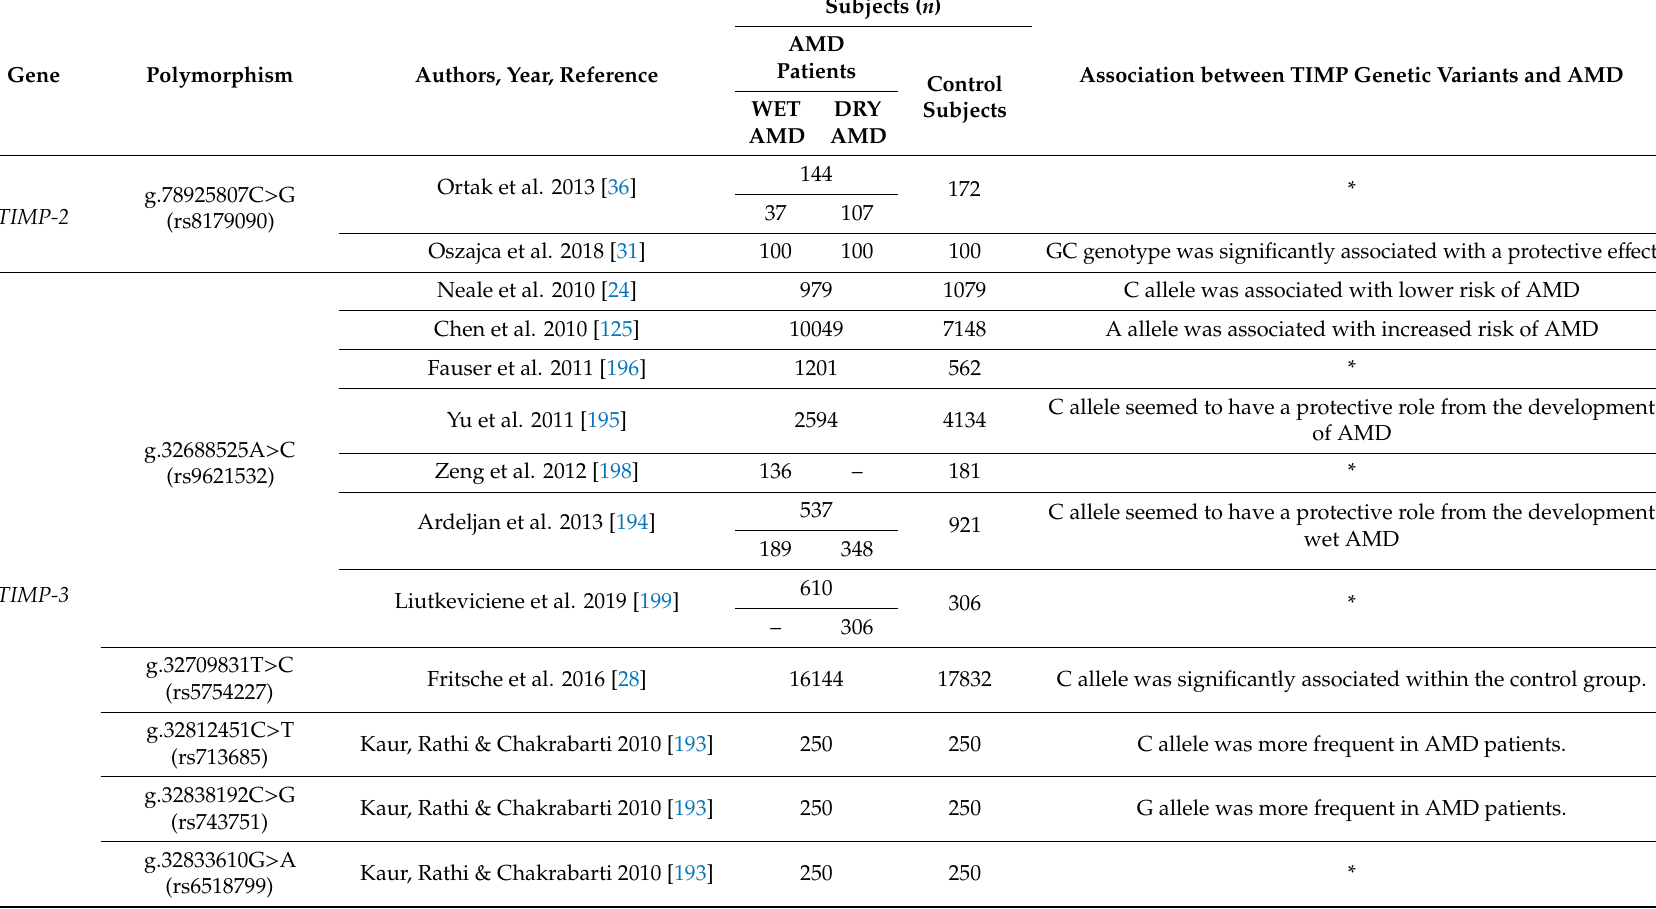
Table 2. TIMPs polymorphisms associated with